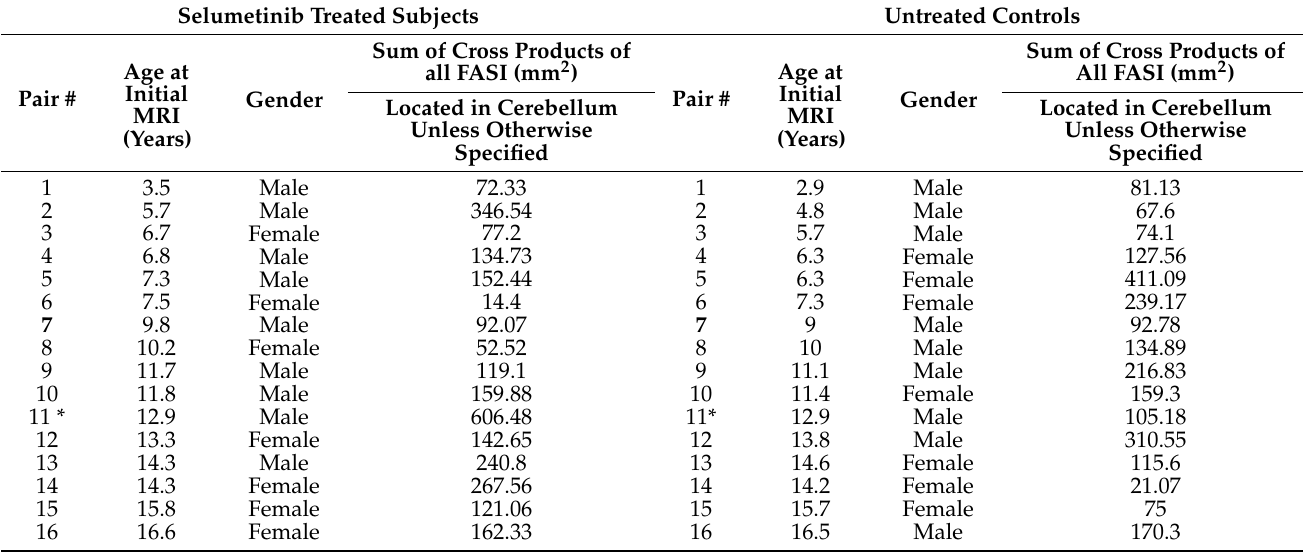
Table 1. Demographics of the paired subjects and controls.